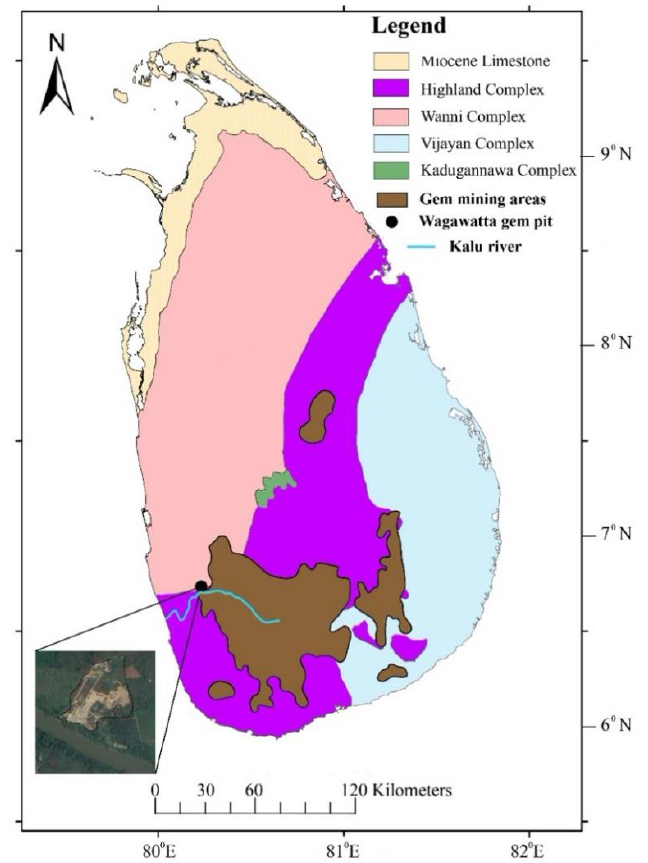
Figure 1. Location of the gem pit in Wagawatta on a simplified geological map of Sri Lanka (source: reproduced from [19] with permission from Precambrian Research) with the main gem mining areas [20].